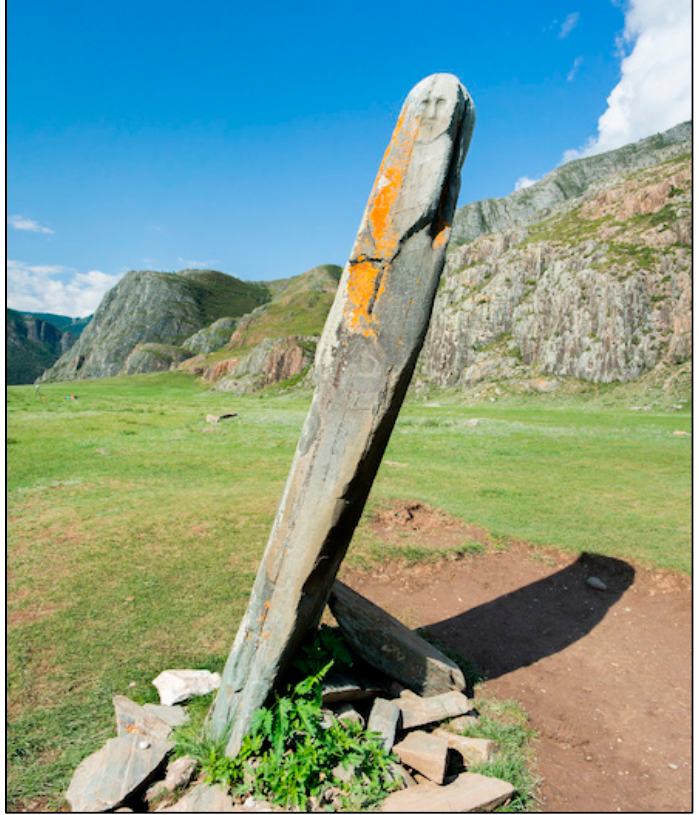
Figure 4. Prehistoric stone tone stele in Adyr ‐ kan, central Altai. Photo: Andrzej Rozwadowski.